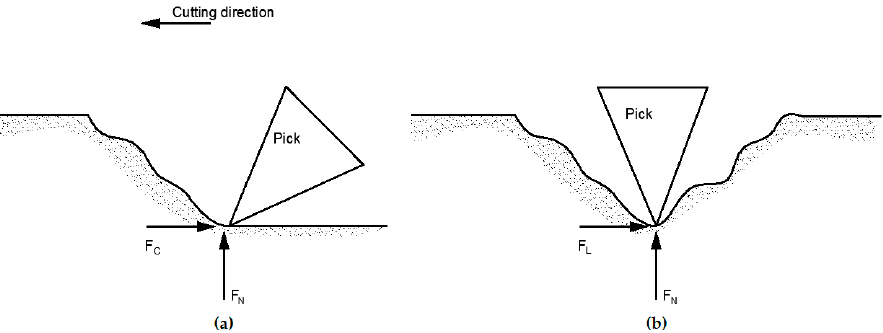
Figure 2. Forces acting on a pick. ( a ) Side view. ( b ) Front view.